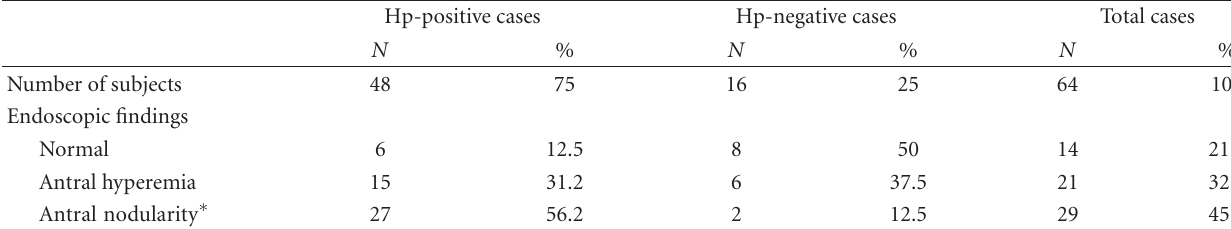
Table 1: Endoscopic findings of Hp-positive and -negative